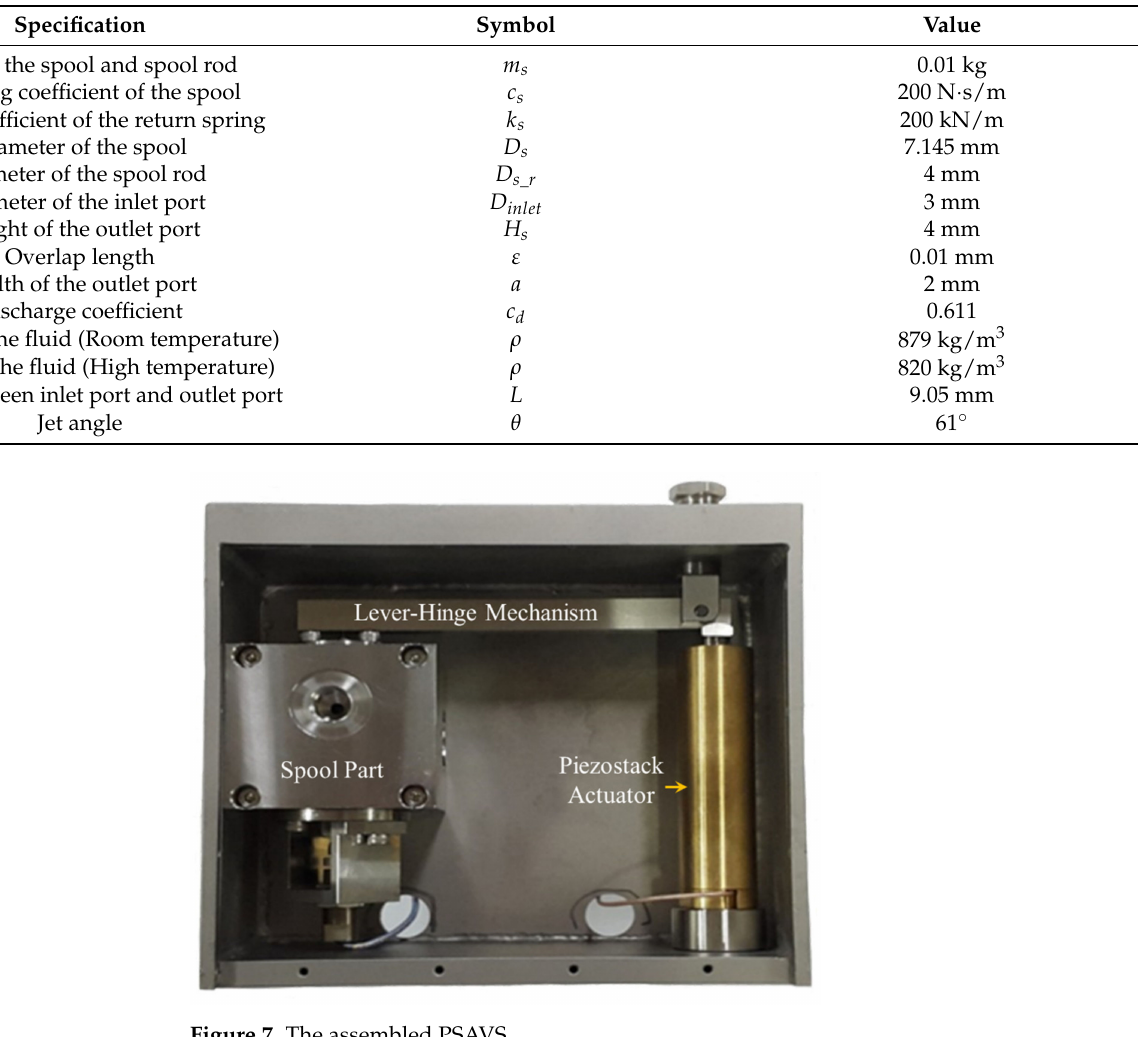
Table 3. Design parameters of the spool part.